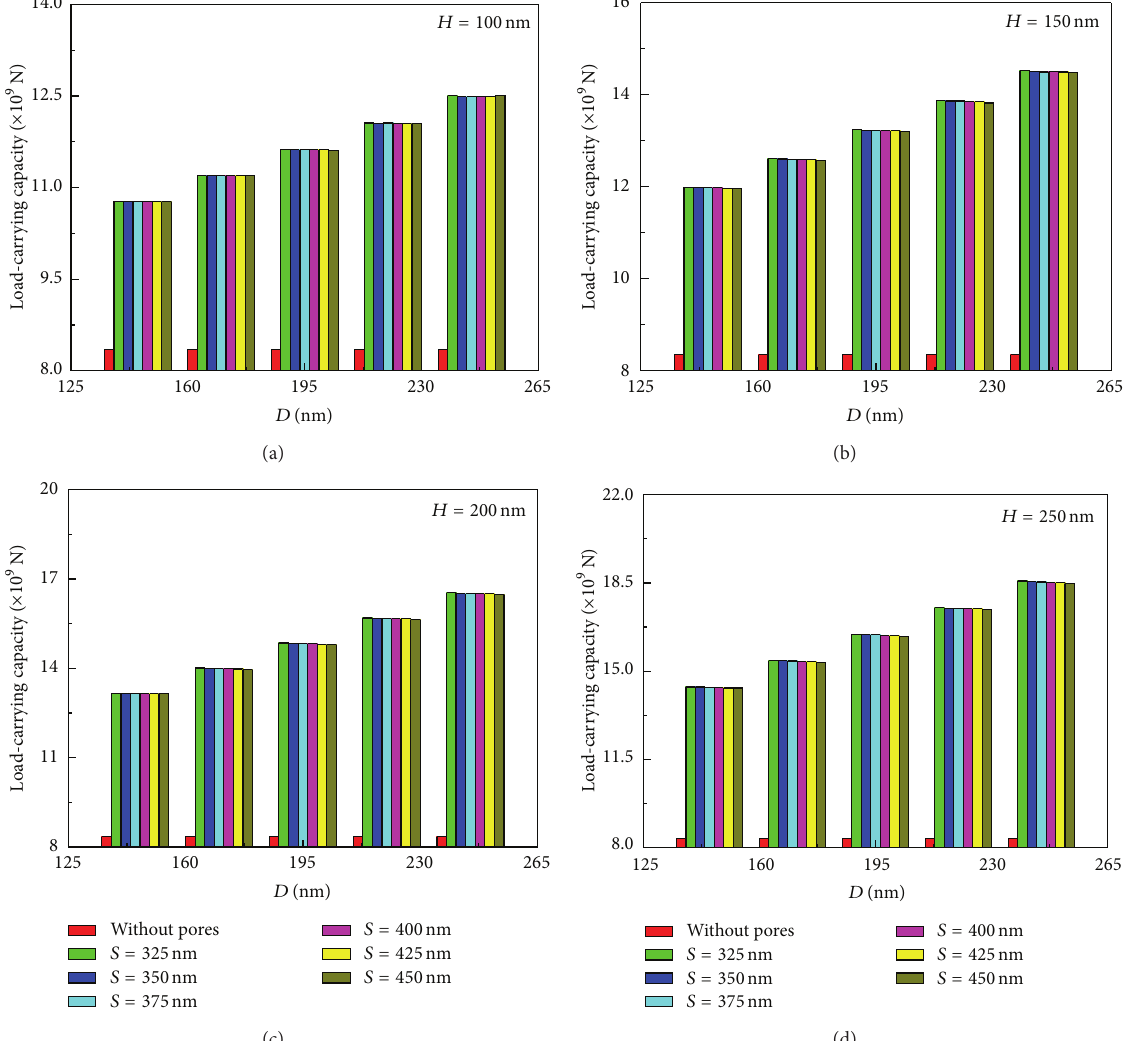
Figure 8: Load-carrying capacities at different intervals of pore: (a) at depth of 100nm, (b) at depth of 150nm, (c) at depth of 200 nm, and (d) at depth of 250